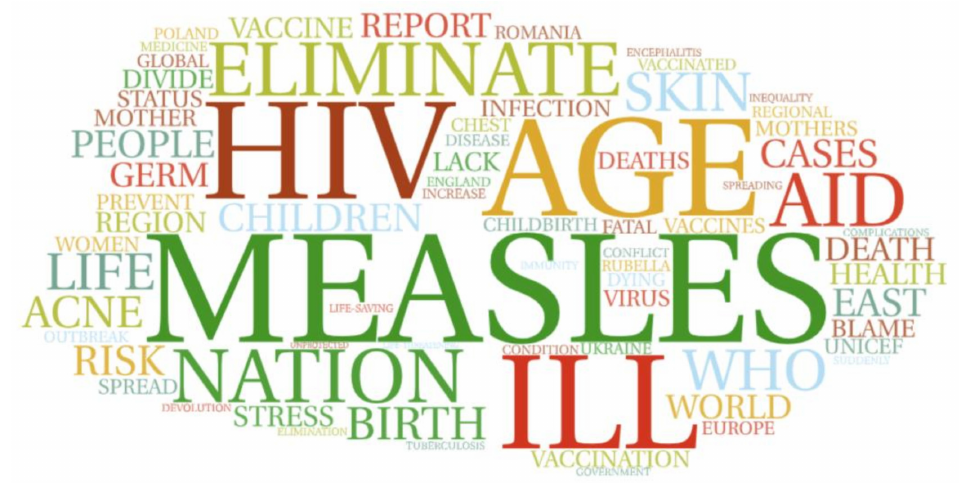
Figure 1. The most frequent words in the health dimension used in the Daily Mail articles concerning Eastern Europe. Source: authors’ elaboration based on